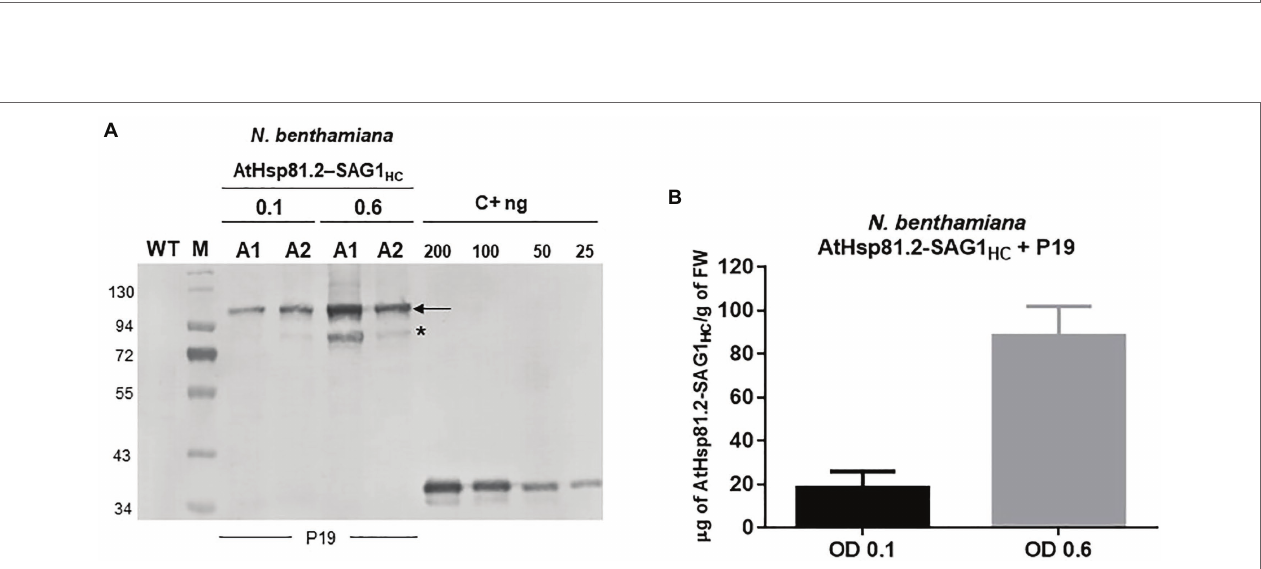
FIGURE 3 | Expression and quantification of plant-produced AtHsp81.2–SAG1 HC . (A) Western blot analysis of fresh material from Nicotiana benthamiana leaves from 6-week-old plants harvested 7 days after two independent syringe agroinfiltrations (A1 and A2) with A. tumefaciens [optical density (OD) 600nm = 0.1 and 0.6, respectively, for A1 and A2]. N. benthamiana leaves were co-agroinfiltrated with the p19 suppressor and AtHsp81.2–SAG1 HC . Serial dilutions of rEcSAG1 m were used as reference for protein quantification. Lanes were loaded with equal (50 μ g) of total proteins for direct comparison. C+, E. coli -purified SAG1 m (rEcSAG1 m ); M, prestained molecular weight protein marker (Fermentas). (B) AtHsp81.2–SAG1 HC accumulation in tobacco leaves. The intensity of the band corresponding to SAG1 expressed in E. coli and detected by Western blot was used build a quantification calibration curve with standard amounts. Leaf-expressed AtHsp81.2–SAG1 HC band intensity in the Western blot was estimated using Gel-Pro analyzer software and compared using the quantification calibration curve.